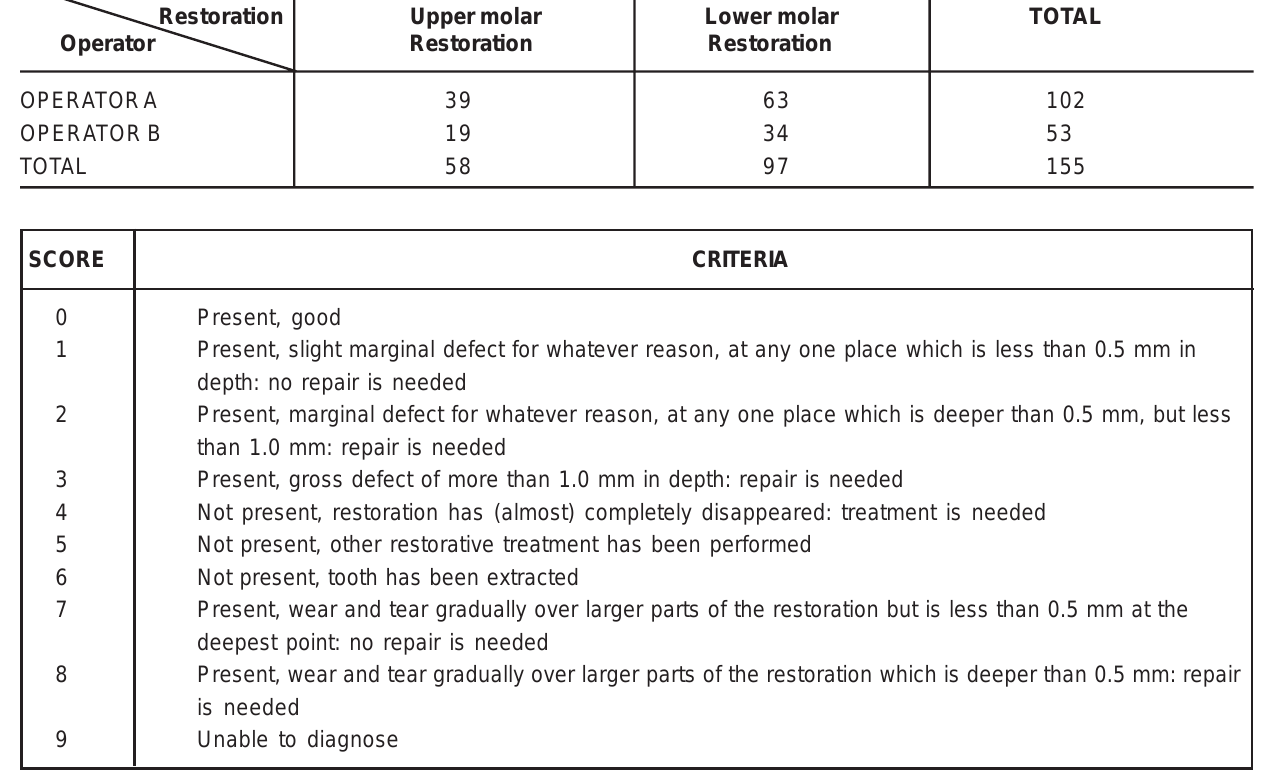
FIGURE 1- Clinical criteria used to evaluate ART